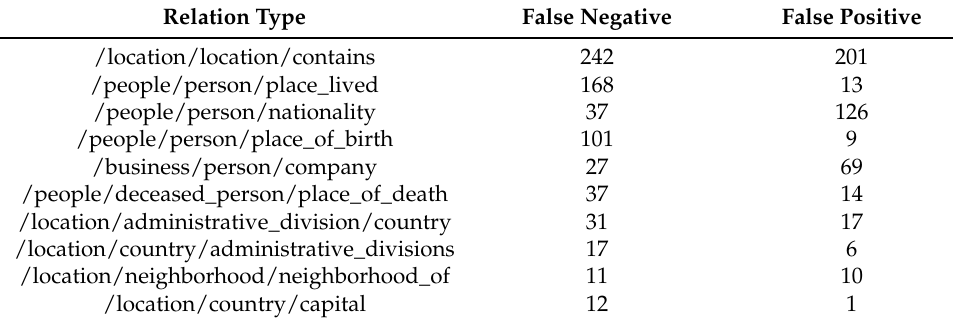
Table 4. False negative/positive relation predictions for NYT-FB.